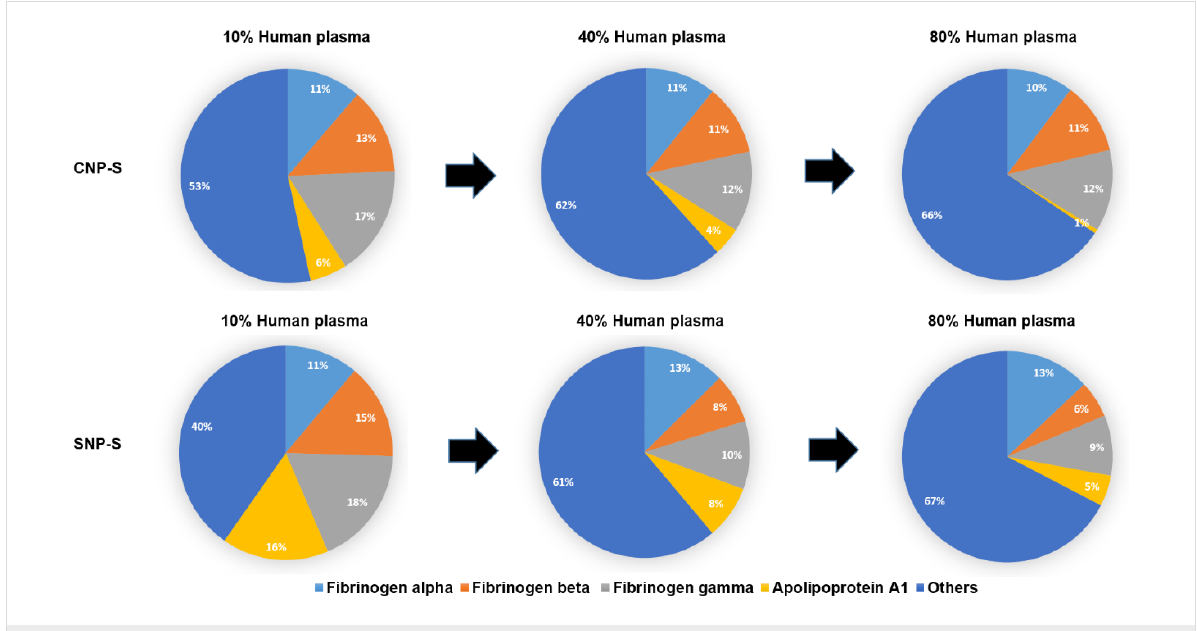
Figure 4: Abundance of fibrinogen and apolipoprotein A1 in silica and carbon nanoparticle corona at different plasma concentrations.